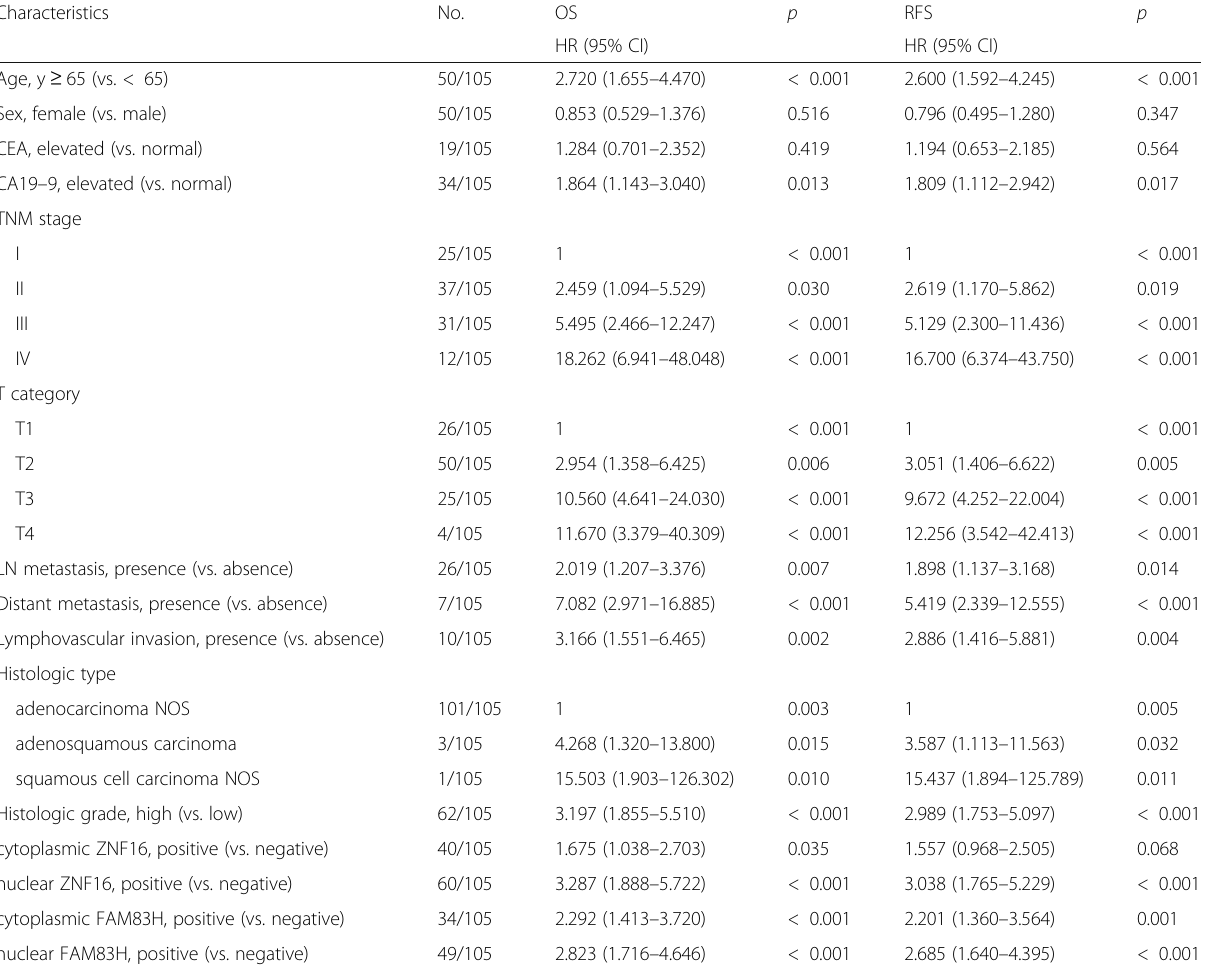
Table 2 Univariate Cox proportional hazards regression analysis for overall survival and relapse-free survival in gallbladder carcinoma patients